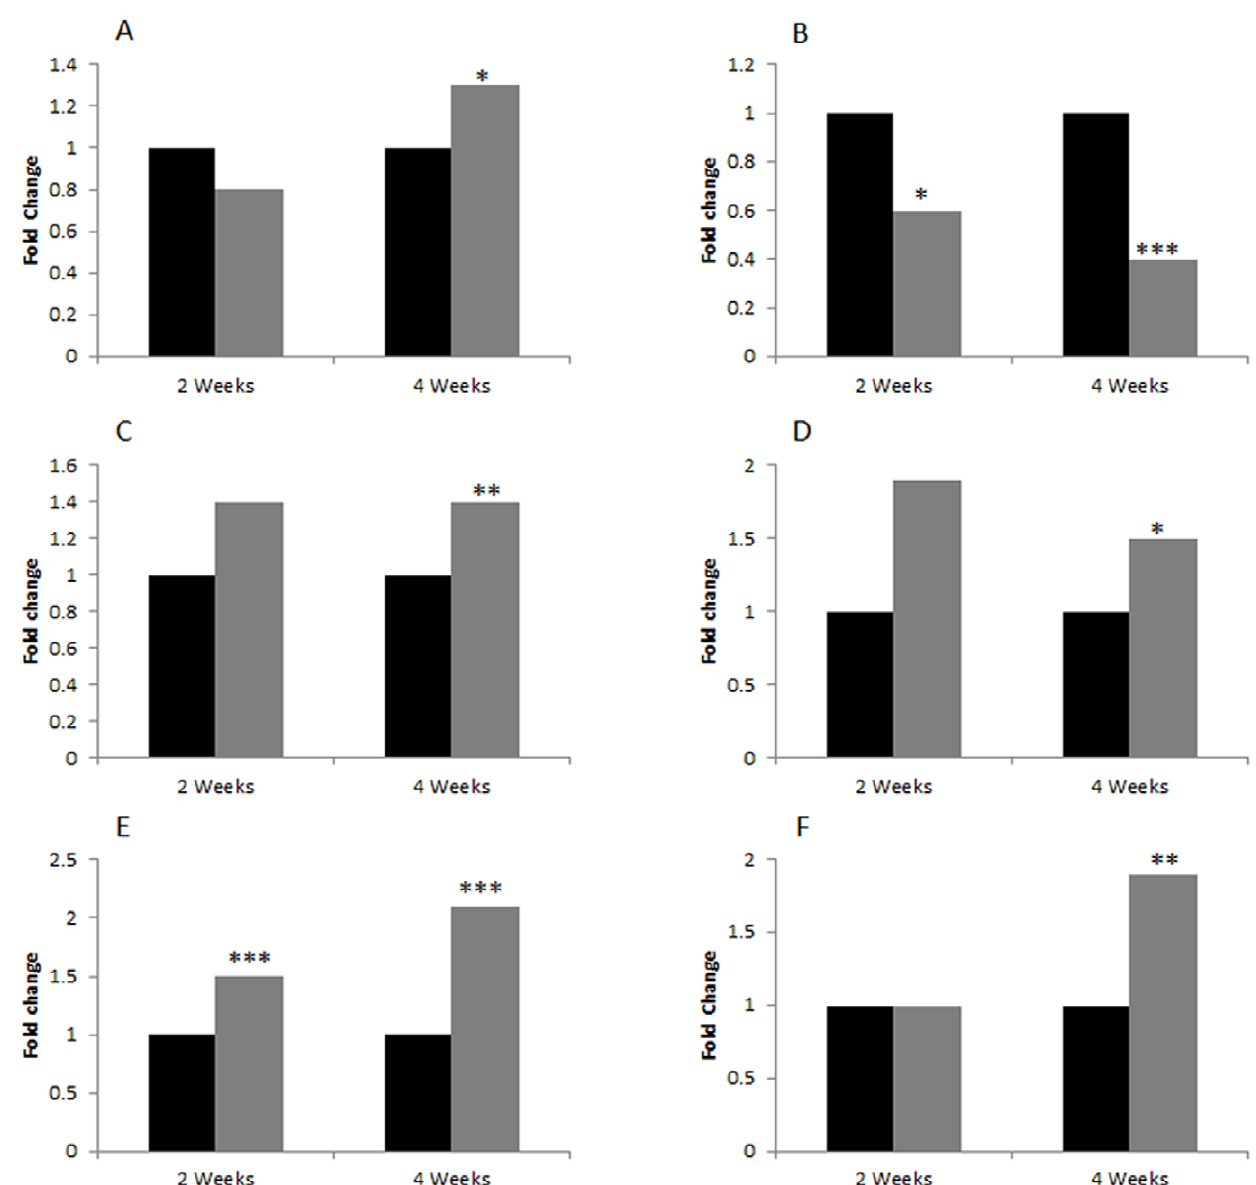
Figure 9. qRT-PCR analysis of miR-186 (A,C,E) and miR-709 (B,D,F) expression level in cerebellum (A,B), hippocampus (C,D), and prefrontal cortex (E,F). Data are represented as a normalized relative fold change to control. Asterisks represent statistical significance (*p , 0.1; **p , 0.05; ***p , 0.001). Control animals are represented in black, stressed animals in grey. For more details see (Tables S7, S8, S9, S10, S11, S12).